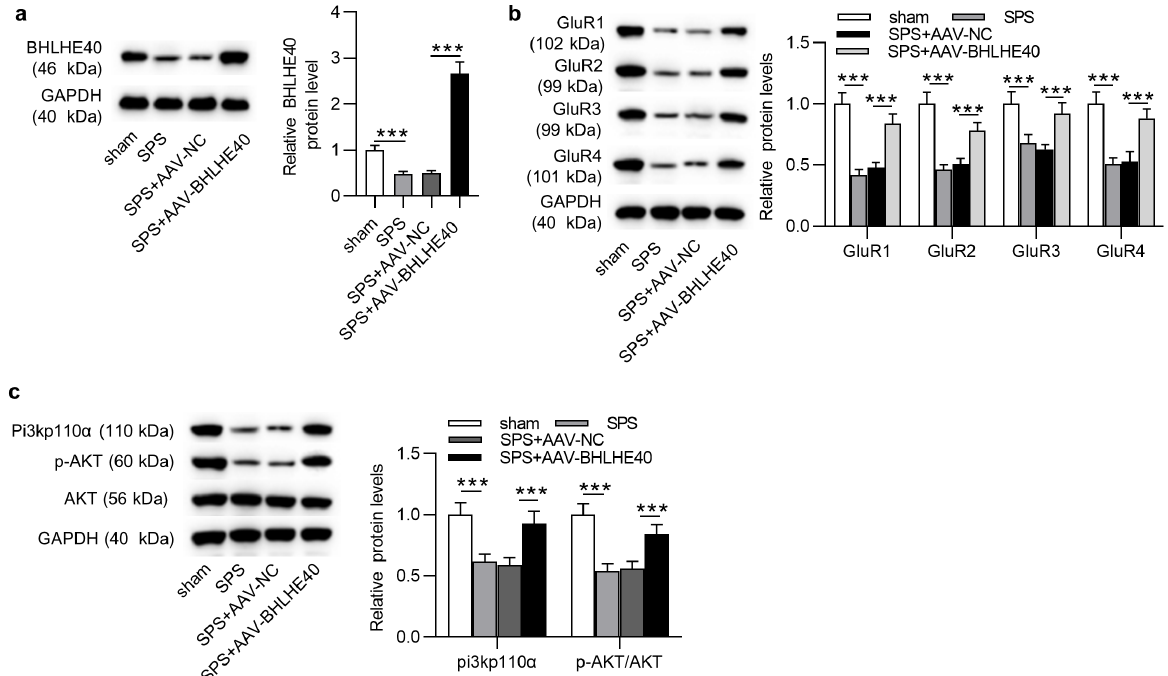
Figure 3. BHLHE40 overexpression promoted protein levels of glutamate receptors and activated the PI3K/AKT signaling pathway. (a) The overexpression efficacy of BHLHE40 in mice of sham, SPS, SPS+AAV-NC, SPS+AAV- BHLHE40 groups (n=9/group) was evaluated by western blot analysis. This experiment was conducted 3 times. (b-c) The protein levels of glutamate receptors, PI3Kp110α, phosphorylated AKT (ser473) and total AKT in mice of sham, SPS, SPS+AAV-NC, SPS+AAV-BHLHE40 groups (n=9/group) were examined by western blot analysis. This experiment was conducted 3 times. One-way ANOVA was applied for data analysis in Figure 3. *** p <